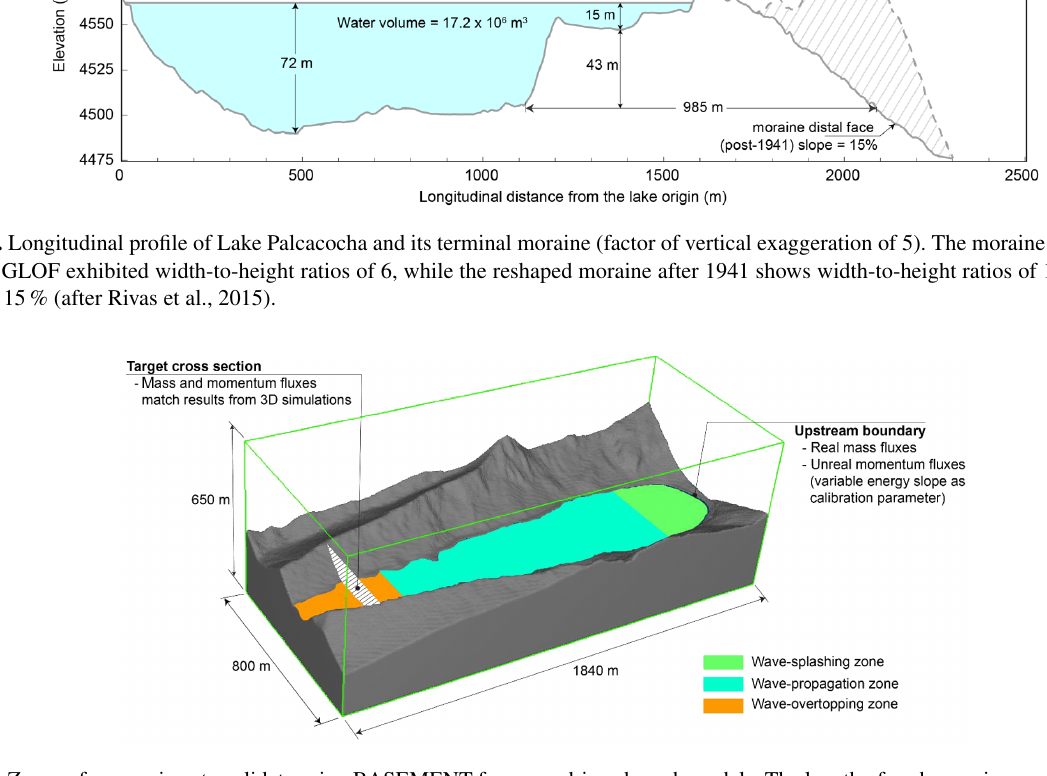
Figure 5. Zones of comparison to validate using BASEMENT for wave-driven breach models. The length of each zone is conceptual and not precise. The locations of the upstream boundary and the target cross section coincide with equivalent flux surfaces in